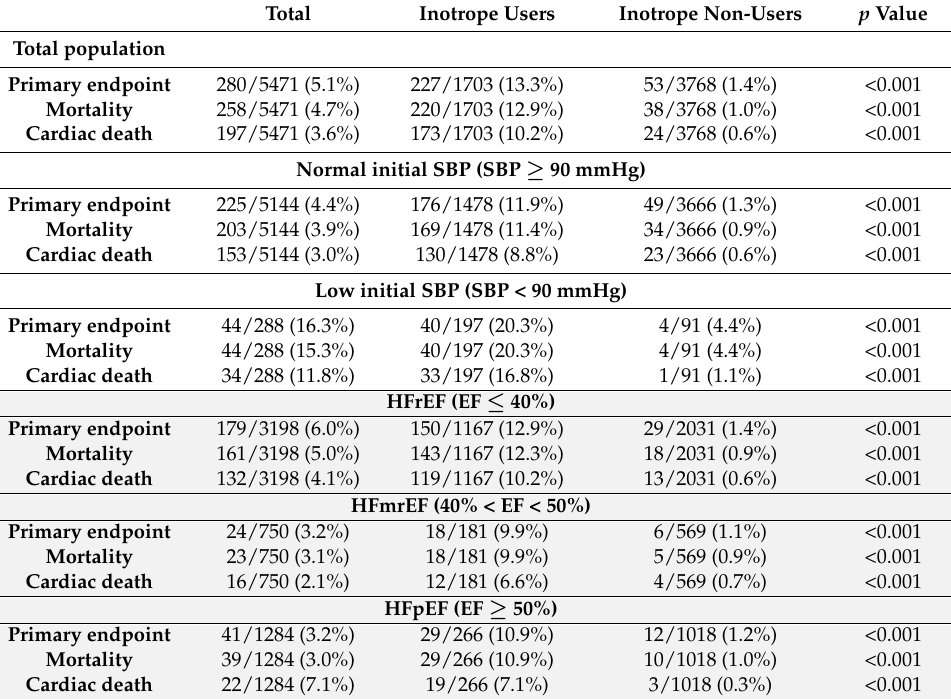
Table 2. In hospital clinical event rate. HFpEF, heart failure with preserved ejection fraction; HFrEF, heart failure with reduced ejection fraction.